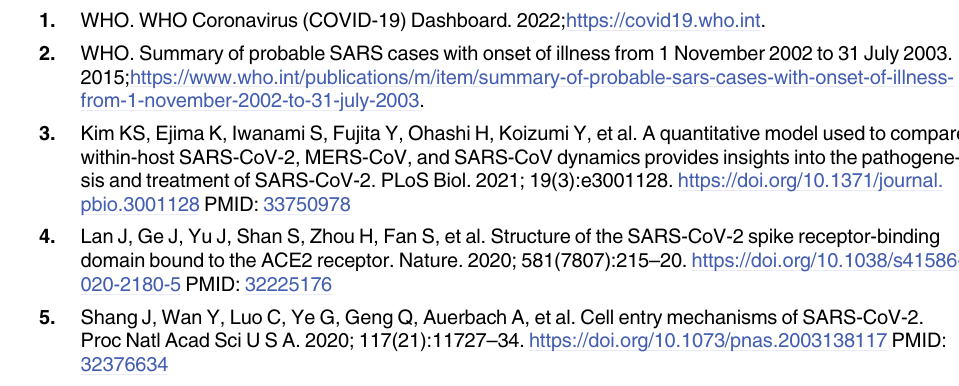
S3 Fig. The detection of sialic acid of the cells treated with or without neuraminidase. VeroE6/TMPRSS2 cells were treated with or without indicated neuraminidases for 2 h at 37˚C, then cells were fixed and sialic acids were detected by lectin staining. Elderberry bark lectin for α 2–6 linked sialic acid and Maackia amurensis lectin II for α 2–3 linked sialic acid. Neuraminidase from Arthrobacter ureafaciens , 100 mU/ml; from Vibrio cholerae , 40 mU/ml; elderberry bark lectin, 20 μ g/ml; Maackia amurensis lectin II, 20 μ